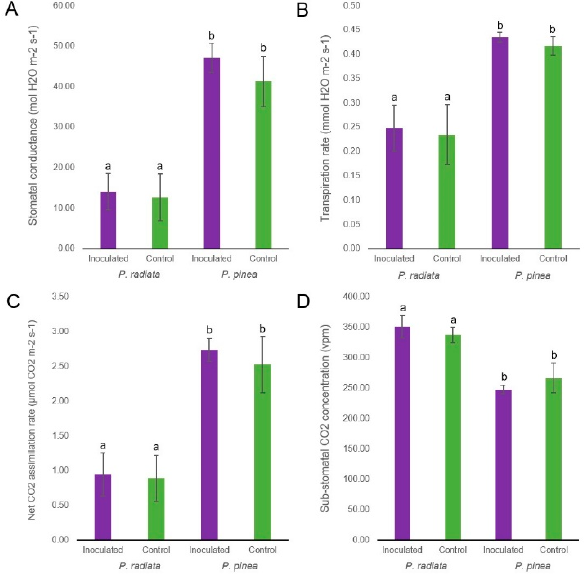
Figure 2. Needle gas exchange-related parameters of P. pinea and P. radiata inoculated with F. circinatum and controls at 4 dpi. ( A ) Stomatal conductance. ( B ) Transpiration rate. ( C ) Net CO 2 assimilation rate. ( D ) Sub-stomatal CO 2 concentration. Error bars show the standard deviation. Different letters above the bars indicate significant differences (ANOVA, p < 0.05).